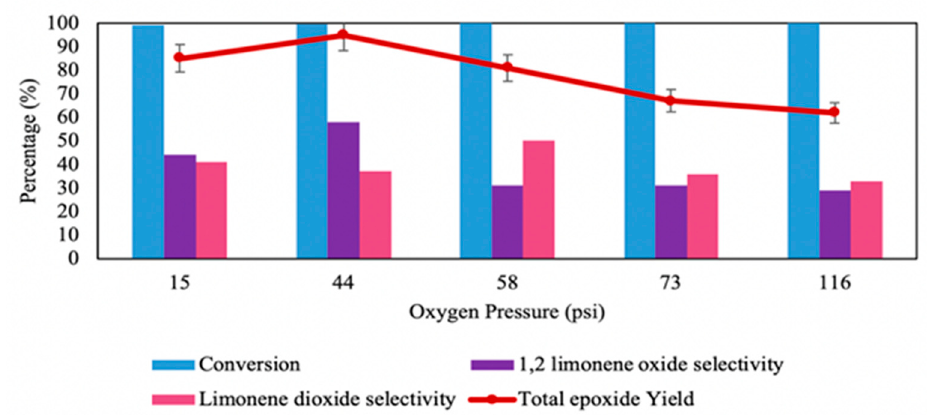
Figure 3. Epoxidation of limonene using Co/SBA16 (Co/Si = 1.1%) catalyst at different oxygen pressures (see Table 2 for reaction conditions). Reproduced from Ref. [52] with permission from Royal Society of Chemistry.